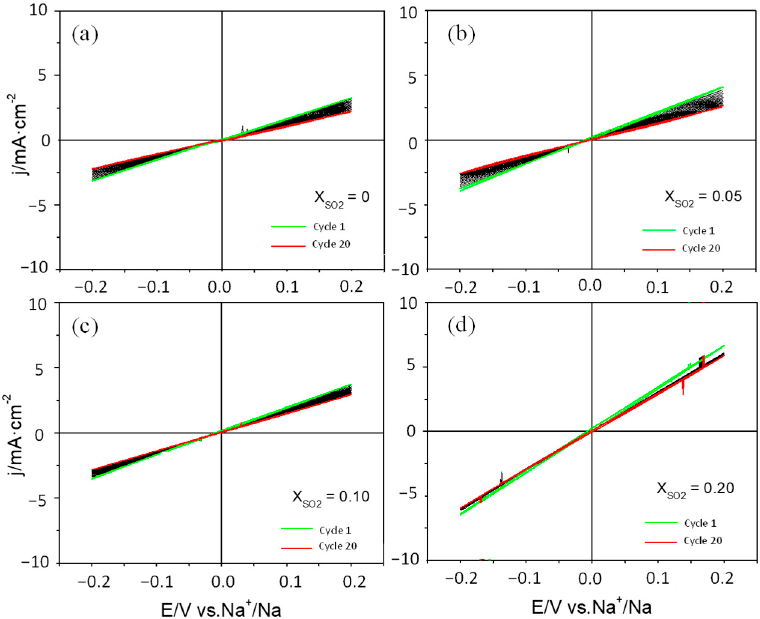
Figure 5. CVs for the Na + /Na process (on Cu) at 20 mV s − 1 for mole fractions of SO 2 : ( a ) 0; ( b ) 0.05; ( c ) 0.10; and ( d ) 0.20 in 1 M NaClO 4 /PC. A thin film of Na was previously deposited in an additive-free electrolyte by applying a potential of − 0.2 V for 500